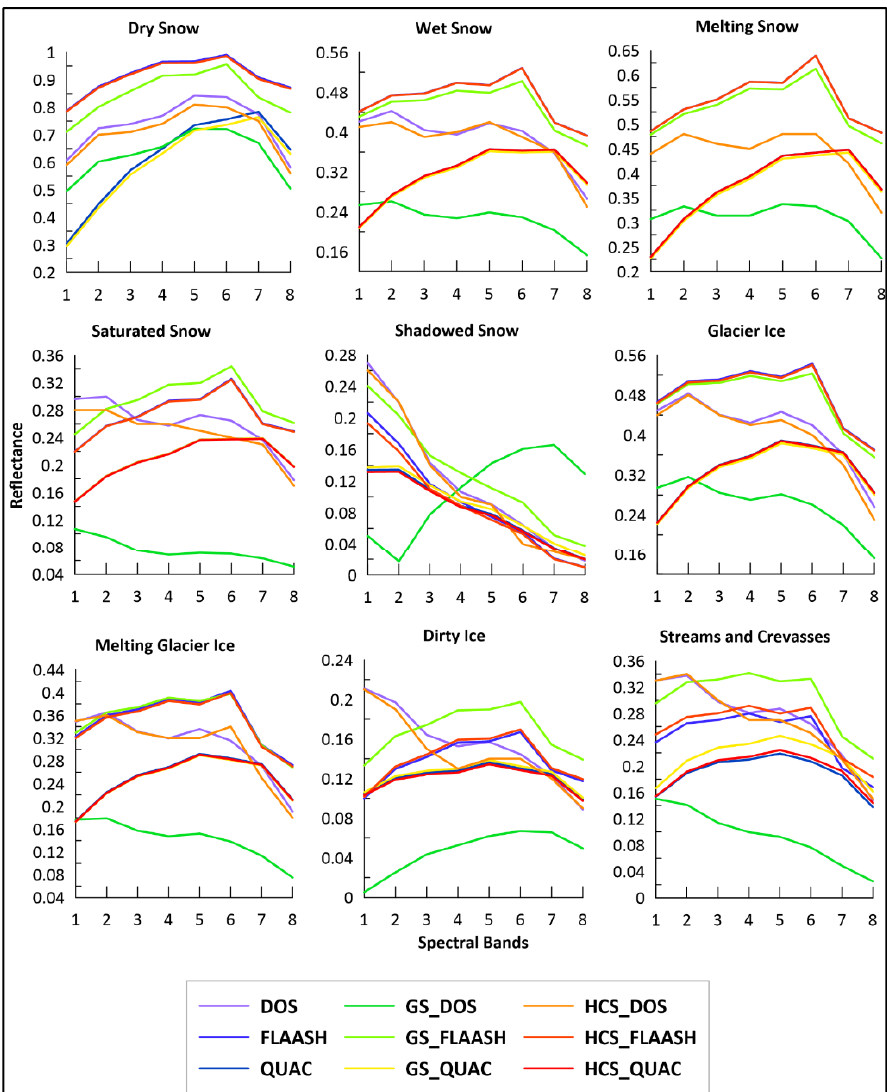
Figure 4. Variations in spectral signatures of identified facies in Ny-Ålesund for each processing scheme. 1: Band 1/Coastal; 2: Band 2/Blue; 3: Band 3/Green; 4: Band 4/Yellow; 5: Band 5/Red; 6: Band 6/Red Edge; 7: Band 7/NIR 1; 8: Band 8/NIR 2.